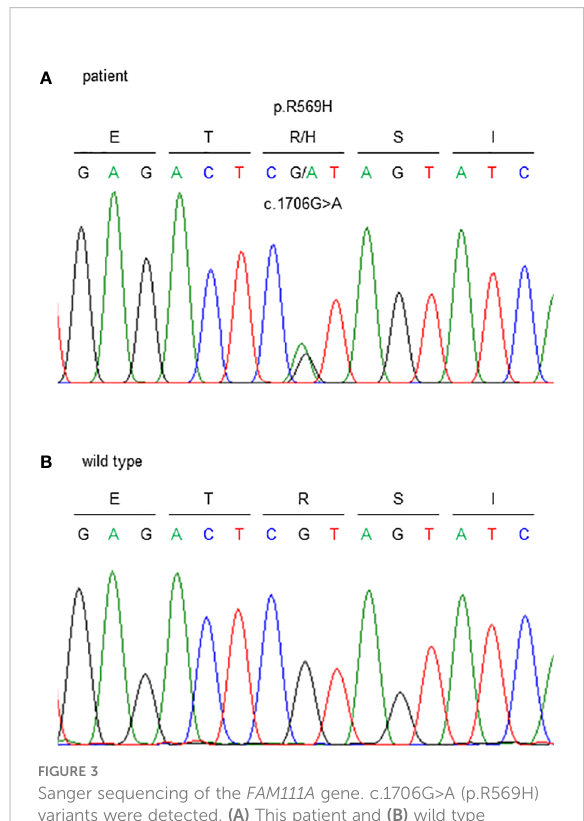
FIGURE 3 Sanger sequencing of the FAM111A gene. c.1706G>A (p.R569H) variants were detected. (A) This patient and (B) wild type (healthy